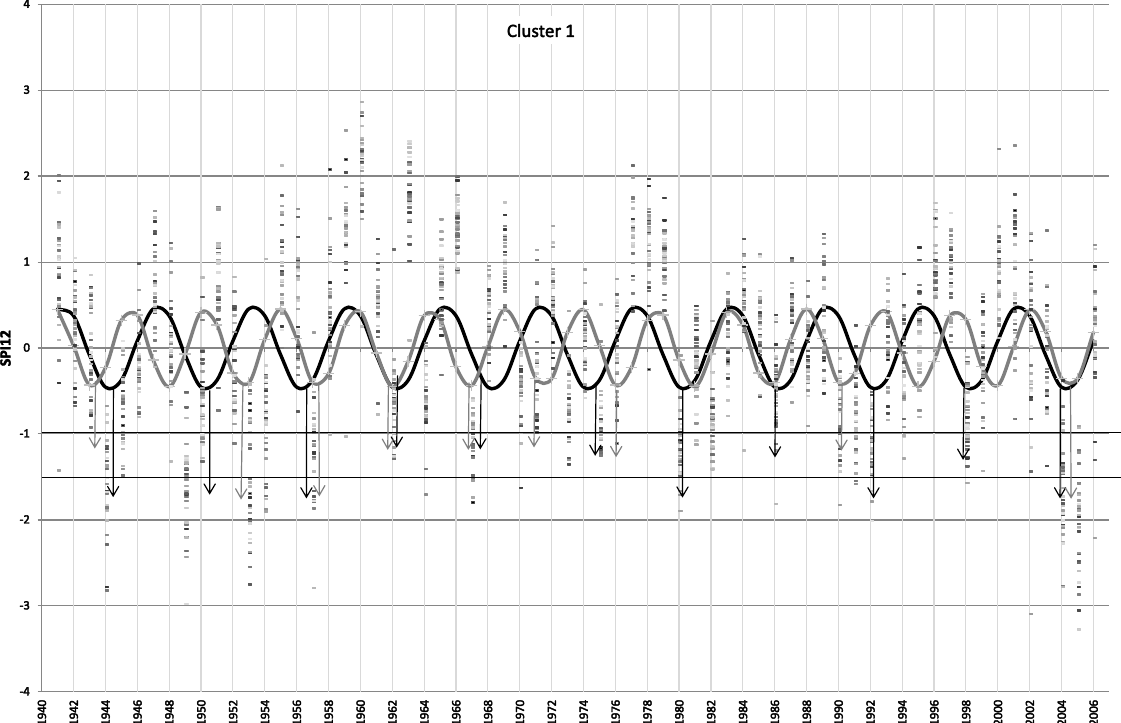
Figure 4. SPI-12 December values for northern Portugal (cluster 1) + waves of period 4.7years (grey line) and 6 years (black line).